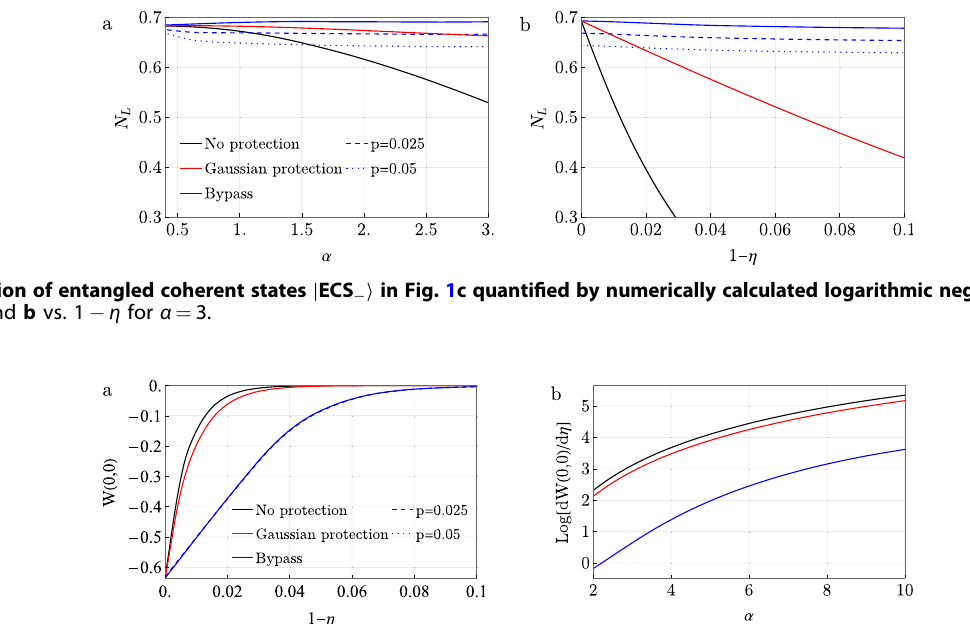
Fig. 5 Protection in Fig. 1 c of the Wigner function negative peak depths at the phase space origin of ECS (cid:1) j i after a projective vacuum measurement on one mode. a vs. loss parameter 1 − η at α = 6 (curves for p > 0 are overlapped), b the logarithm of the slope of the curves in a . The curves for the protection by squeezing were calculated numerically. The dephasing noise does not affect the depth of the negative peaks, as is evidenced by the overlap of the curves.